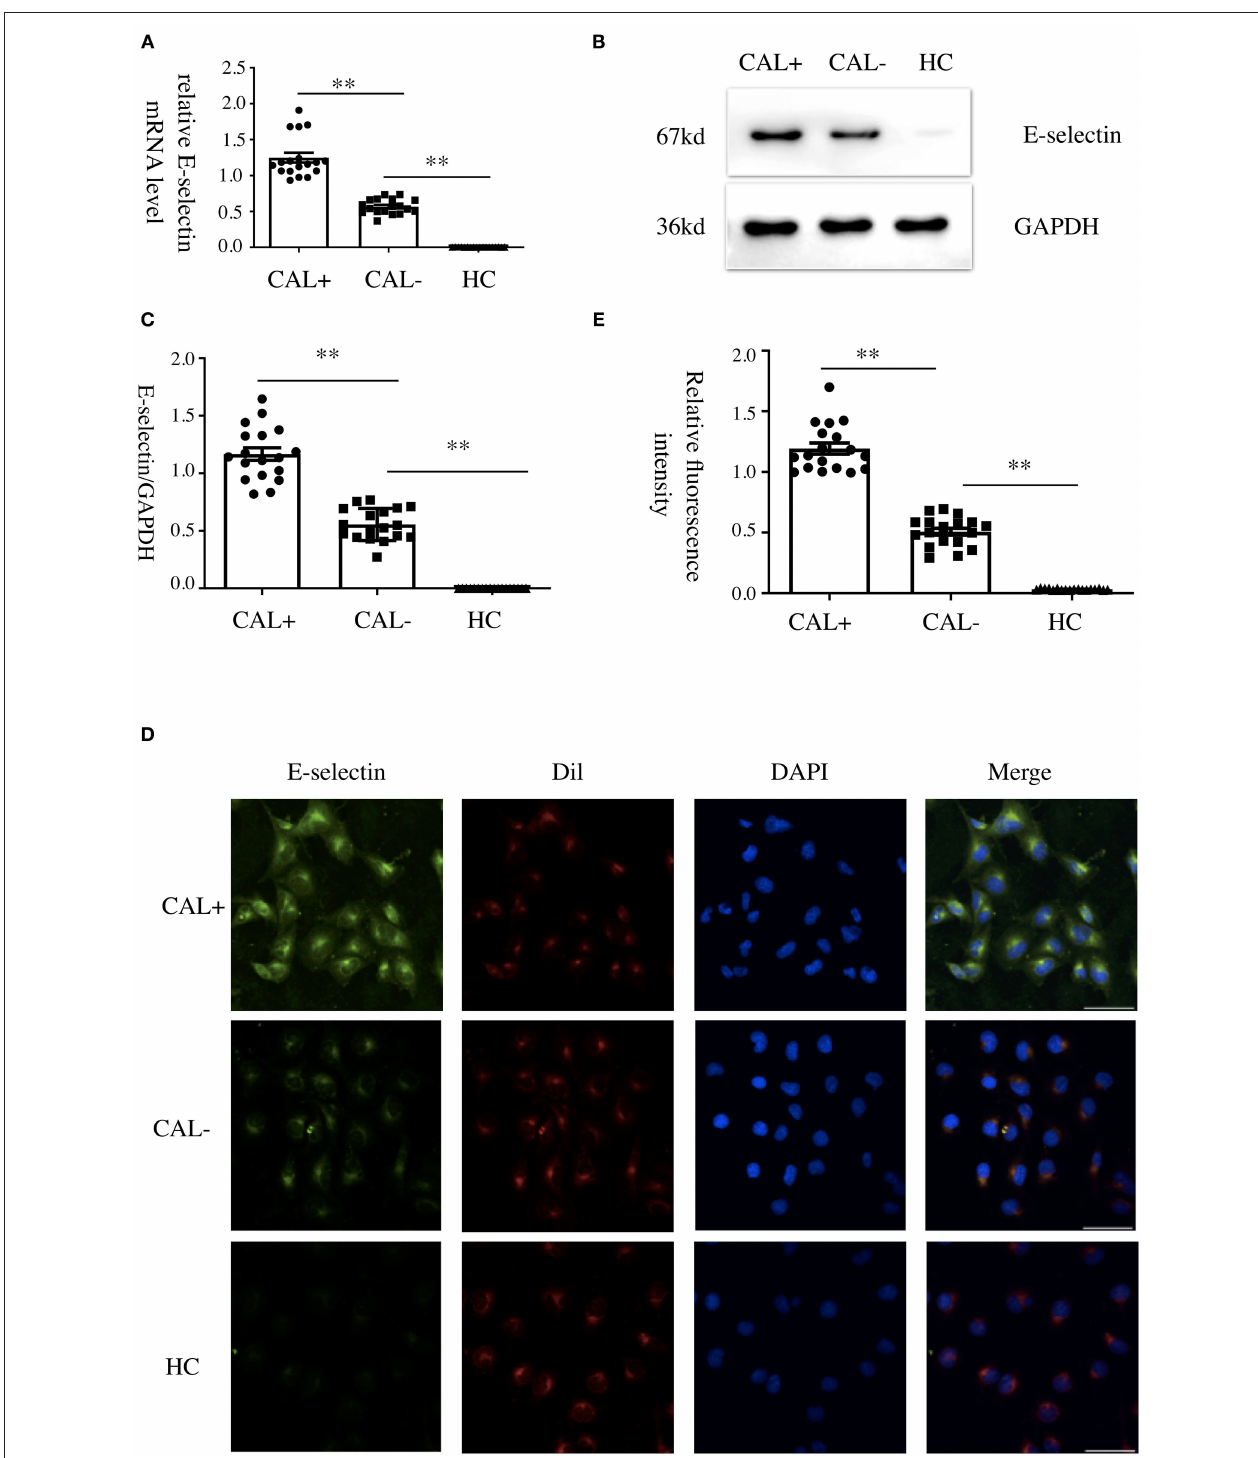
FIGURE 1 | Kawasaki disease (KD) sera increased E-selectin level in human coronary artery endothelial cells (HCAECs). (A–C) HCAECs were treated with medium containing 15% sera from healthy controls (HCs; n = 6), KD without coronary artery lesion (KD-CAL–; n = 6), and KD with coronary artery lesion (KD-CAL + ; n = 6) for 4h. The E-selectin mRNA levels were measured by qPCR ( A , HC = 6, KD-CAL– = 6, KD-CAL + = 6), and protein levels were measured by Western blot ( B , HC = 6, KD-CAL– = 6, KD-CAL + = 6). (C) Statistical analysis of immunoblots. (D,E) HCAECs were treated with medium containing 15% sera from HCs ( n = 6), KD-CAL– ( n = 6), and KD-CAL + ( n = 6) for 4h; localization and expression of E-selectin (green) in HCAECs were measured by immunofluorescence. (D,E) Statistical analysis of immunofluorescence. The bar graphs are mean ± SEM. ** P < 0.01 compared with the indicated group.